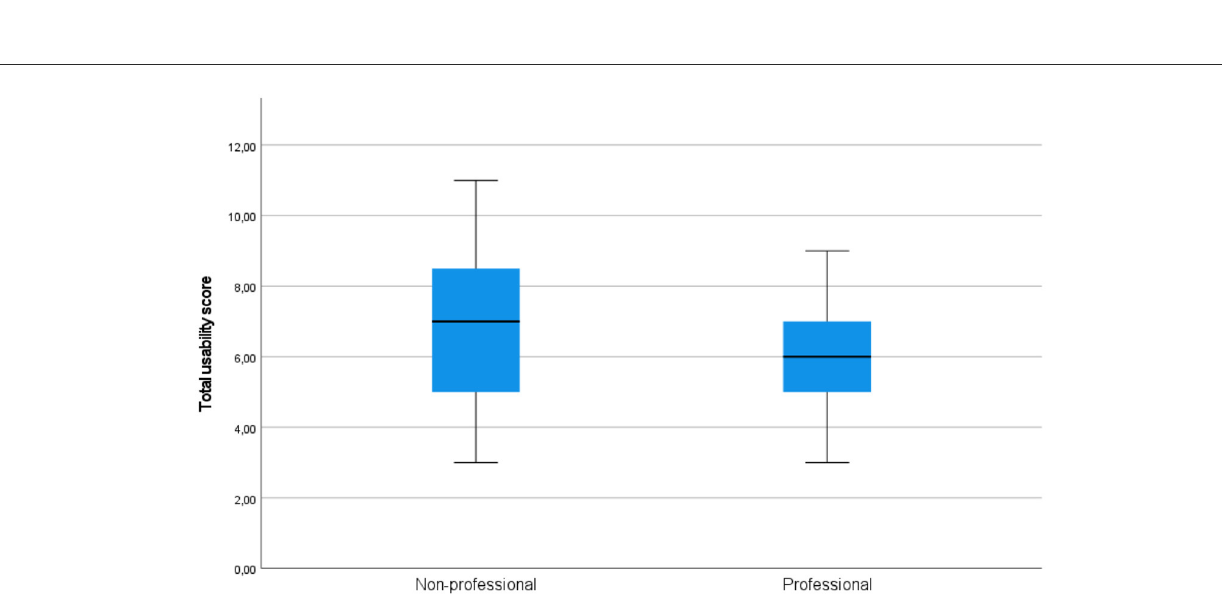
FIGURE4 Total usability scores in the groups of professional and non-professional users of machine